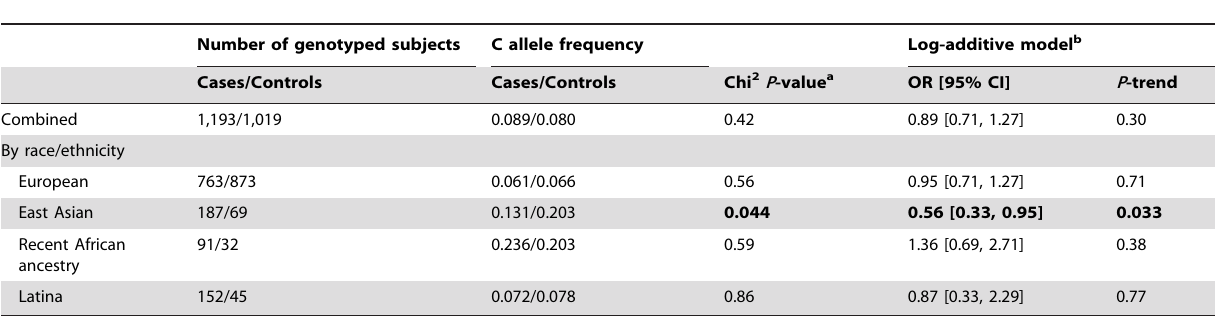
Table 2. Stratified analyses of the RAD51 2 135G/C SNP on breast cancer risk in the